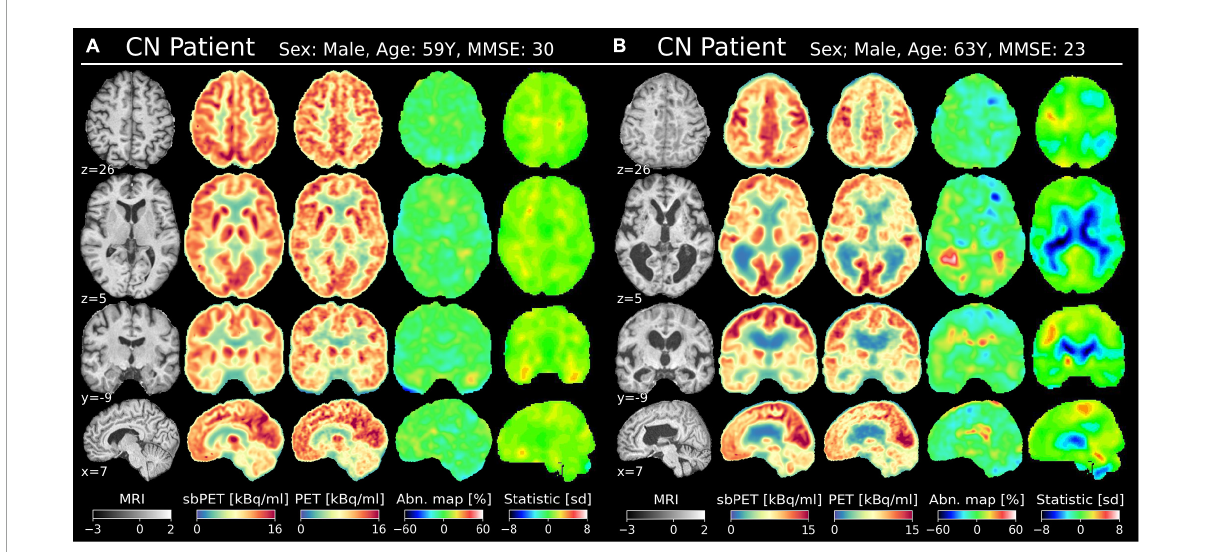
FIGURE6 Two CN subjects in MNI space (affine transformation); one with minimal atrophy (A) and one with substantial atrophy (B) . The MNI coordinate is denoted for each view. Columns from the left: T1w MRI (normalized intensity), sbPET (post-normalized), true PET, abnormality map, vendor-provided statistical map.